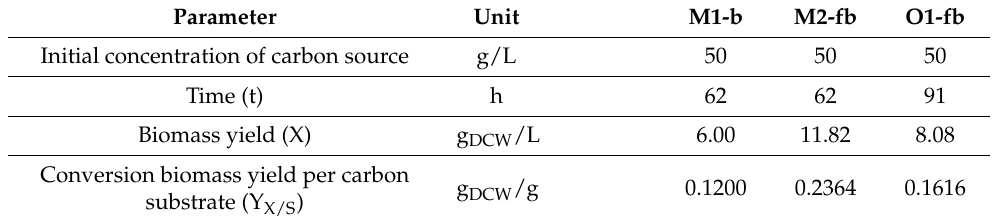
Figure 2. Cellular lipid content of Y. lipolytica KKP 379 during batch culture in medium M1-b and fed-batch cultures in medium O1-fb and M2-fb. Table 1. Parameters of Y. lipolytica KKP 379 yeasts strain culture in media M1-b, M2-fb and